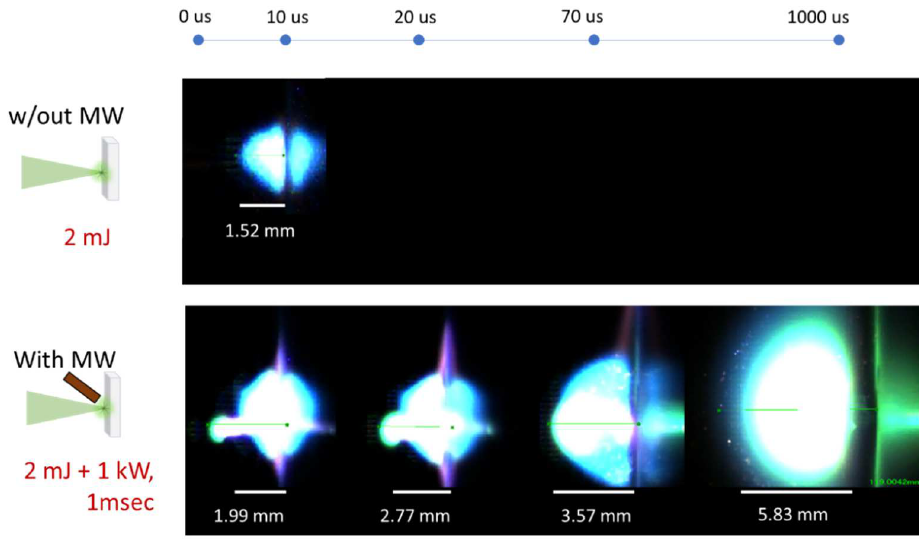
Figure 2. High-speed images of LIBS with, and without, the microwave.